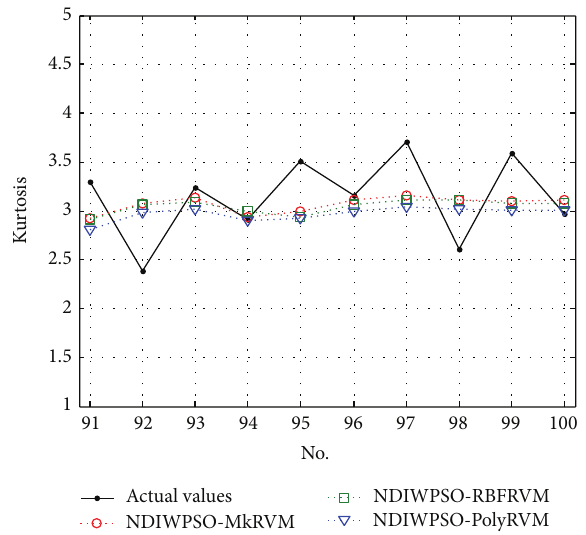
Figure 2: The comparison of the prediction results for kurtosis of bearing vibration signal among NDIWPSO-MkRVM, NDIWPSO- RBFRVM and NDIWPSO-PolyRVM in case 1.